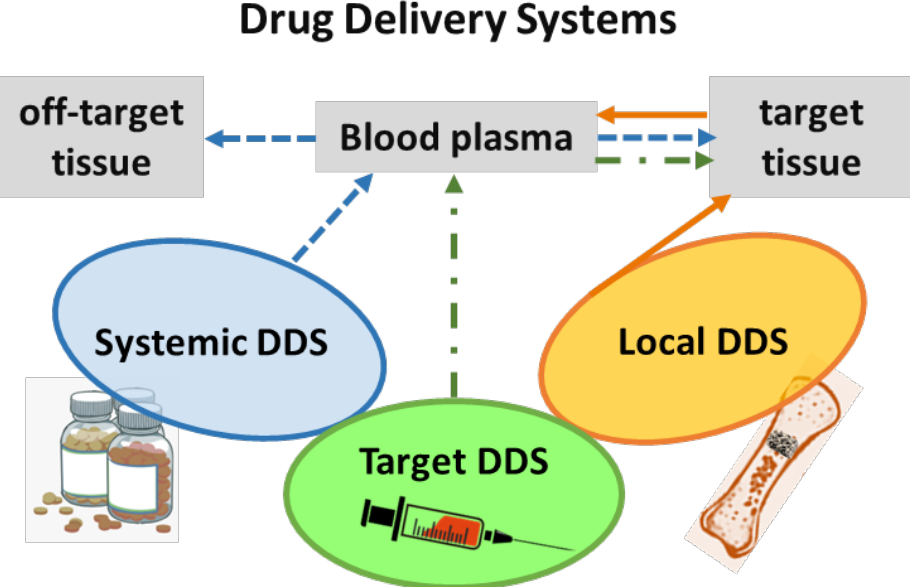
Figure 14. Classification of the Drug Delivery Systems considering the administration route.